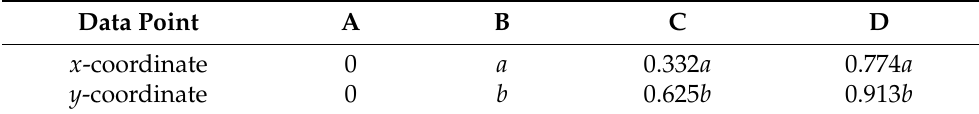
Table 3. Data points definition for the parametric NURBS curve to be